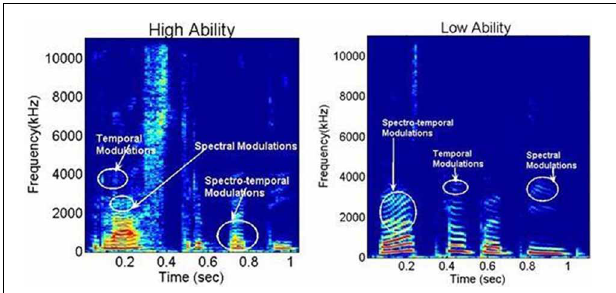
FIGURE 1 | Representative spectrograms from the High and Low Ability groups, for the Hindi word /Rashtrapati/ (meaning “president”), demonstrating spectral, temporal, and spectro-temporal modulations. X-axis: time in ms; Y-axis spectral frequency in kHz. Notice the differences in energy distribution in the spectro-temporal modulations around 0.3s time between the two